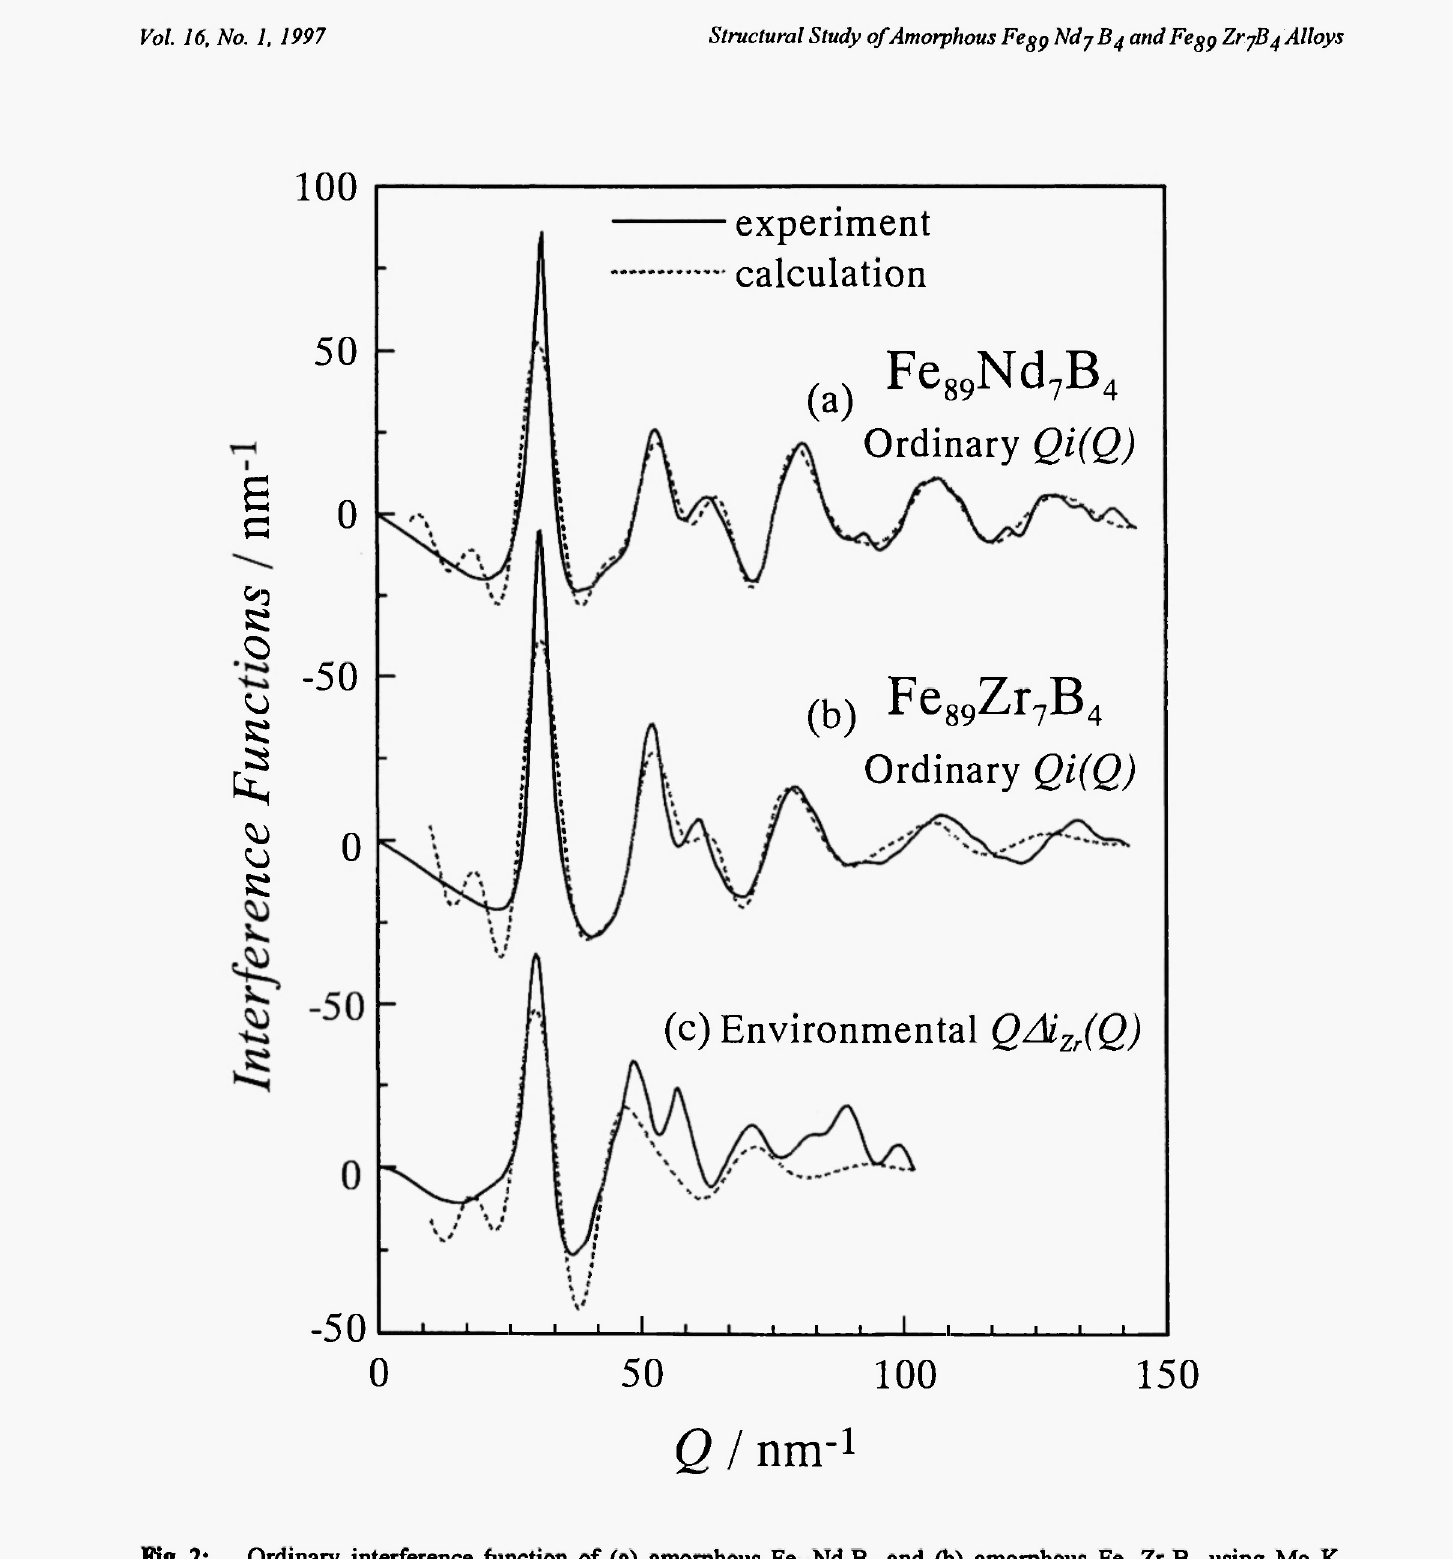
Fig. 2: Ordinary interference function of (a) amorphous FeggNd^ and (b) amorphous Fe89Zr radiation, and (c) environmental interference function of Fe89Zr scattering measurements at incident energies of 25 and 300 eV below the Zr Κ absorption edge. Solid lines denote the experimental data and dotted lines are the calculated values by the least-squares variational